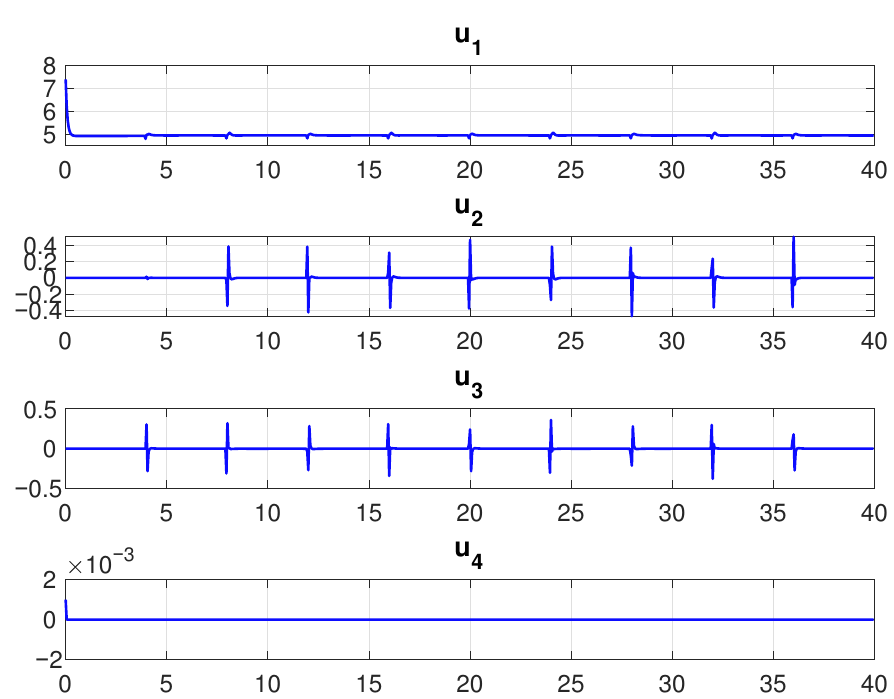
Figure 12. Signals ( u 1 , u 2 , u 3 , u 4 ), calculated by PD control optimized with 100 individuals.